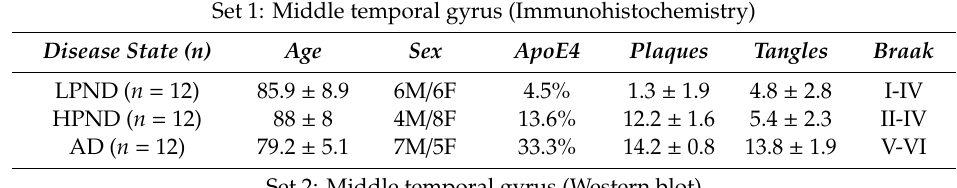
Table 1. Demographic details of human brain cases used.